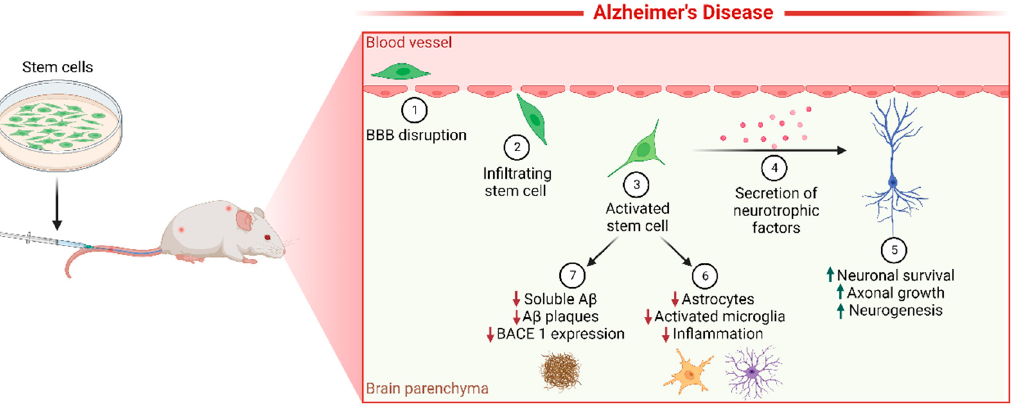
Figure 2. Stem cell-mediated delivery of neuroprotective factors as a model for AD treatment. MSCs and NSCs can cross BBB in response to stimuli produced by neurodegeneration and inflammation such as HGF in AD (1 and 2). Engineered stem cells can secrete neuroprotective factors such as GDNF (3 and 4) and improve neuronal survival, axonal growth, and neurogenesis (5). Furthermore, MSCs decrease proinflammatory mediators, increase anti-inflammatory molecules and reduce A β accumulation (6) in animal AD models. AD, Alzheimer’s disease; MSCs, Mesenchymal stem cells; NSCs, Neural stem cells; BBB, Blood brain barrier; HGF, Hepatocyte growth factor; GDNF, Glial derived neurotrophic factor; A β , Amyloid β peptide. Figure created with Biorender.